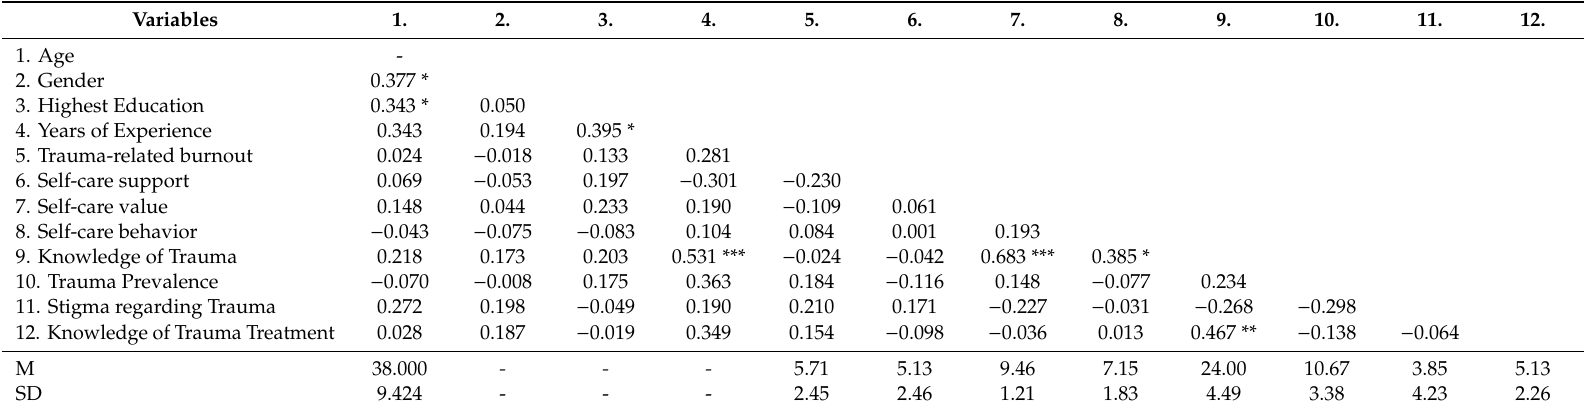
Table 2. Correlations between demographic characteristics and self-reported trauma knowledge, trauma stigma, and self-care prior to workshop. Variables